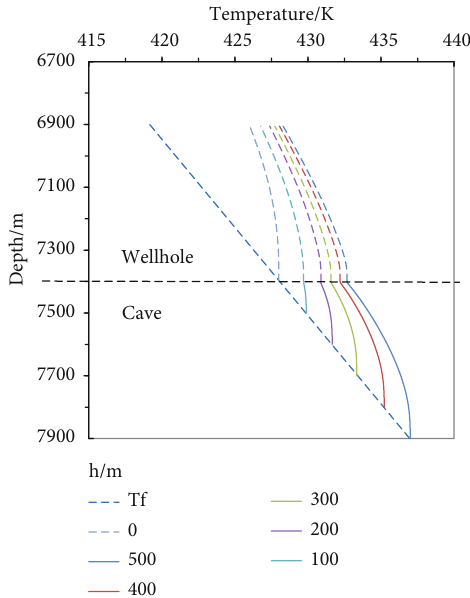
Figure 10: The temperature in the cave and